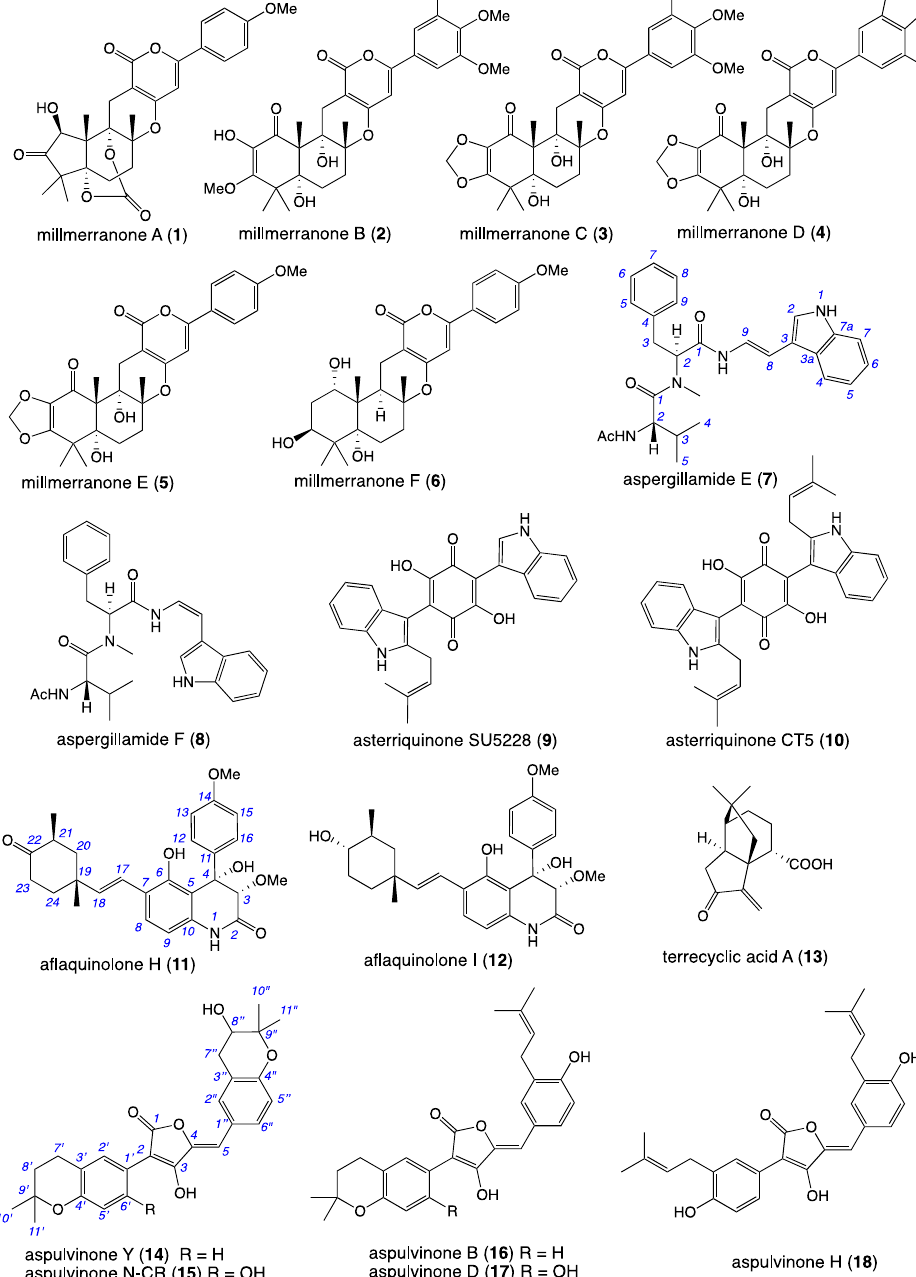
Figure 1. Natural products from Aspergillus sp. CMB-MRF324.